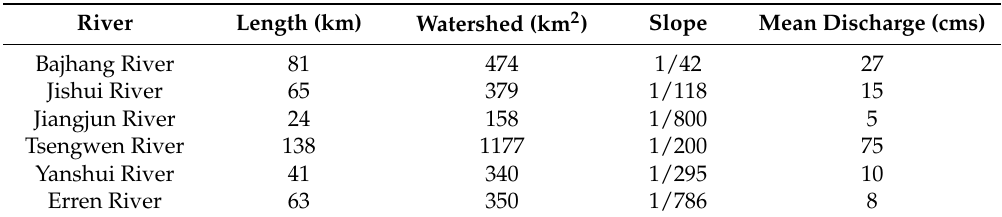
Table 2. List of rivers run through Tainan City.